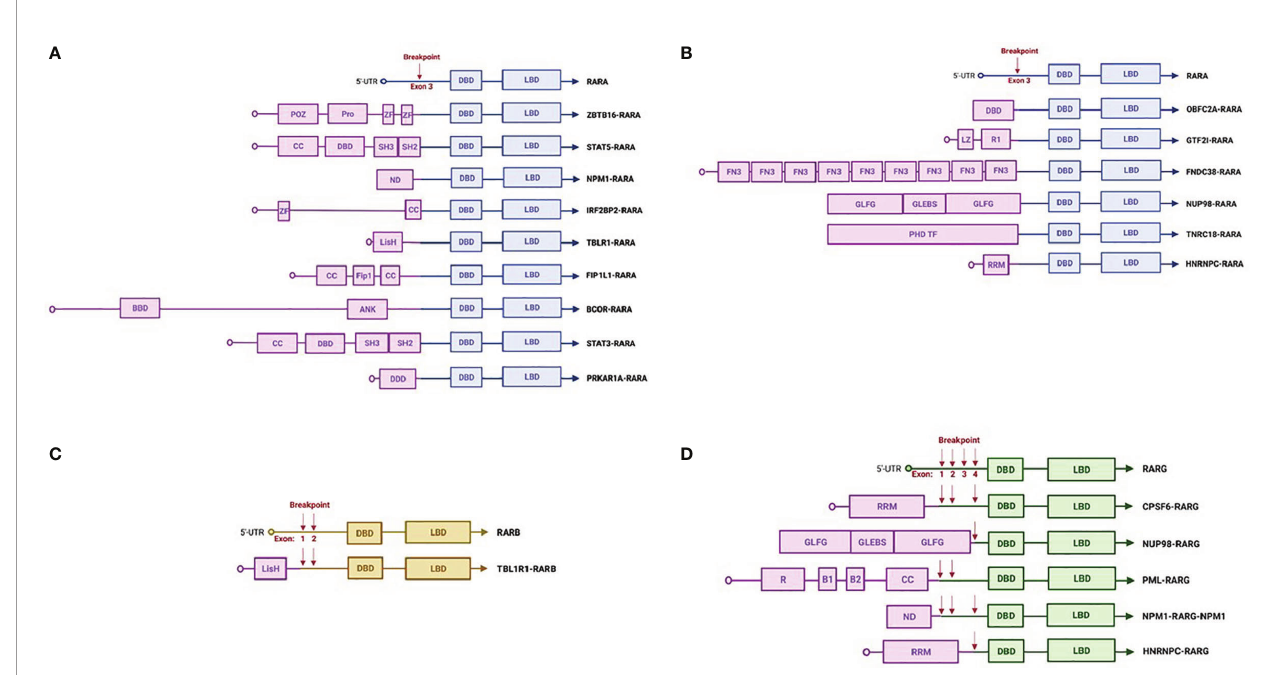
FIGURE 1 | Schematic representations of RARx translocations. Common (A) and rare (B) RARA rearrangements. RARB (C) and RARG (D) rearrangements. The fi gures were created with Biorender.com. 5 ′ -UTR, 5 ′ -untranslated region; DBD, DNA-binding domain; LBD, ligand-binding domain; CC, coiled coil domain; POZ, BTB/POZ domain; Pro, proline-rich region; Zn, zinc fi nger domain; SH3, protein – protein interaction domain; SH2, docking domain for phosphorylated tyrosine residues; BBD, BCOR Bcl6-binding domain; ANK, ankyrin repeats; Fip1, FIP1-binding domain for polymerase; LisH, lissencephaly type-1-like homology motif; DDD, dimerization/docking domain of the type I alpha regulatory subunit of cAMP-dependent protein kinase; ND, nucleoplasmin/nucleophosmin domain; LZ, leucine zipper; PHD TF, plant homeodomain fi nger transcription factor domain; FN3, fi bronectin type 3 domain; GLEBS, Gle2/Rae1-binding sequence; GLFG, Gly-Leu-Phe- Gly repeats; R1, I-repeat domains; RRM, RNA recognition motif; R, RING fi nger domain; B1 and 2, B